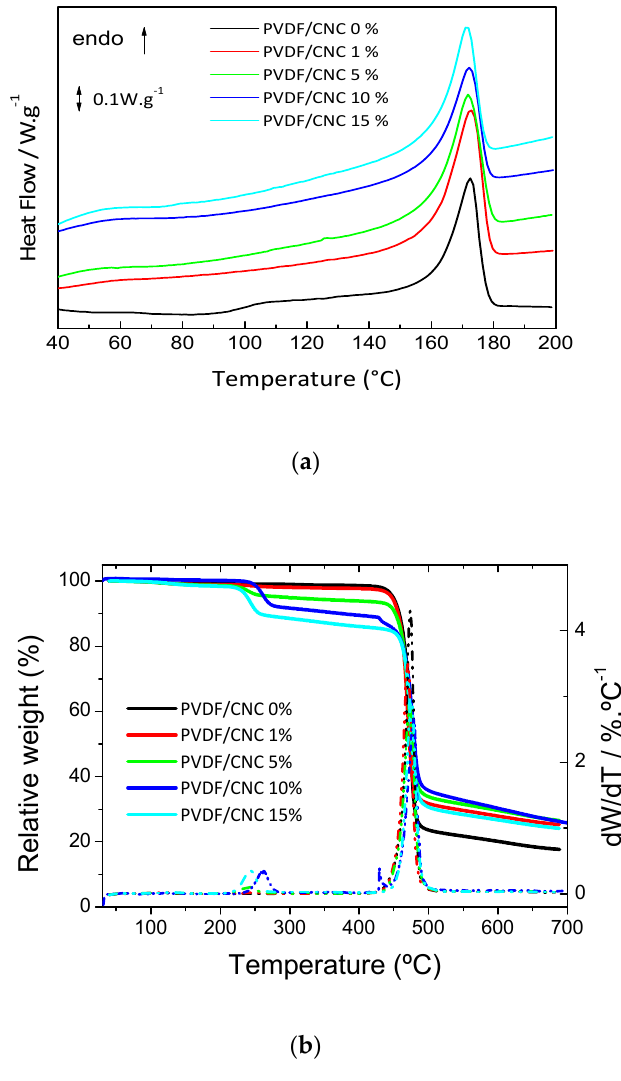
Figure 4. ( a ) DSC heating curves and ( b ) TGA traces of the PVDF/CNC nanocomposites.